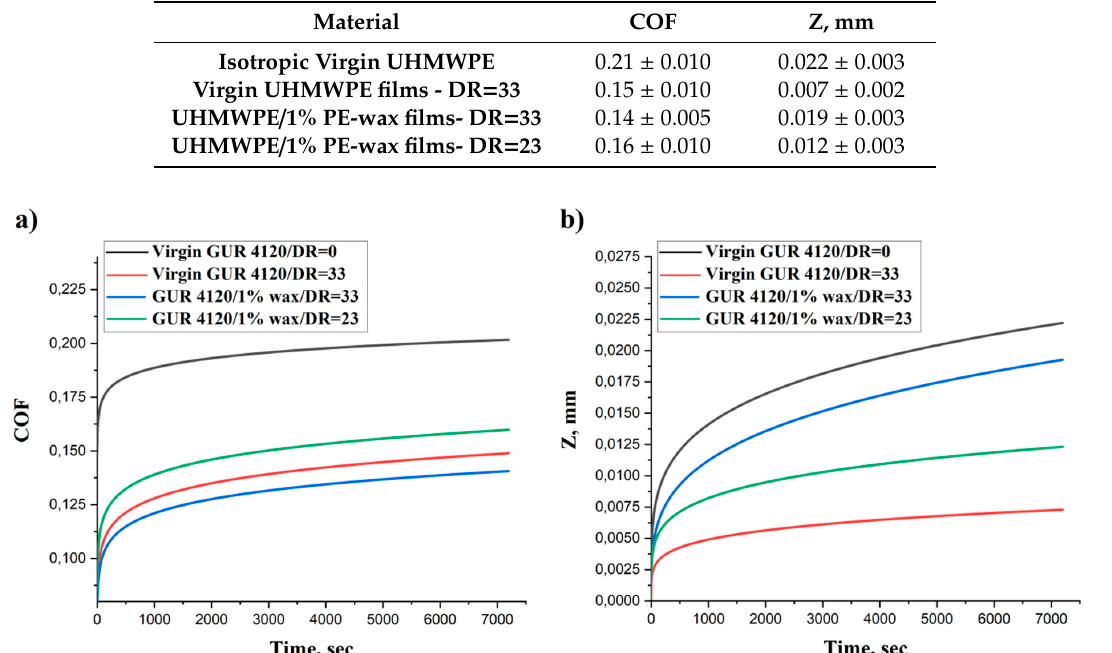
Figure 12. Coe ffi cient of friction ( a ) and wear ( b ) curves for isotropic UHMWPE and virgin UHMWPE Figure 12. Coefficient of friction ( a ) and wear ( b ) curves for isotropic UHMWPE and virgin film in comparison with UHMWPE / PE-wax films with di ff erent draw ratio UHMWPE film in comparison with UHMWPE/PE-wax films with different draw ratio values.